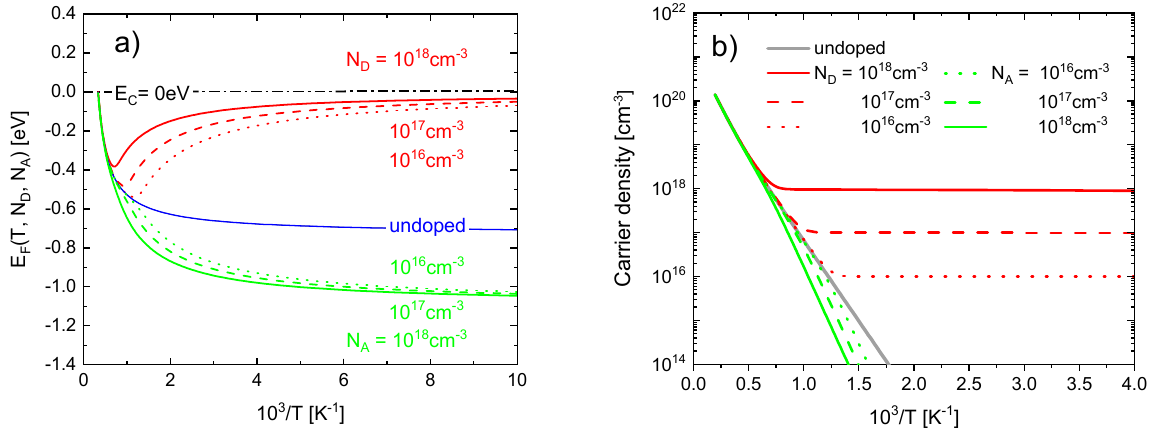
Figure 8. ( a ) Effect of n- and p-type impurity doping on Fermi energy position within the forbidden gap, and ( b ) on mobile charge carrier concentrations.